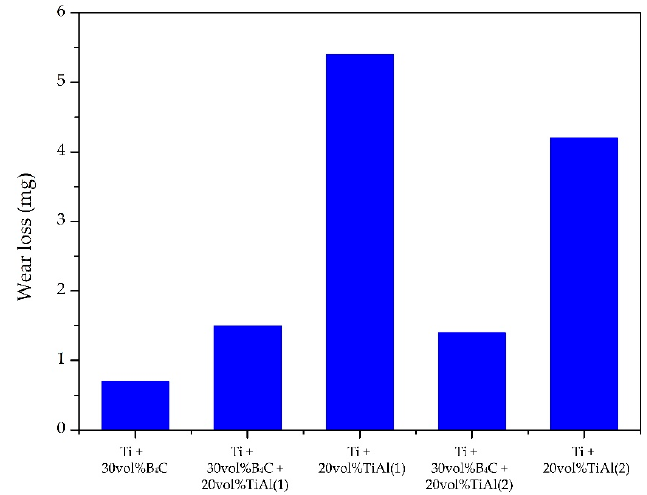
Figure 9. Wear loss vs. specimens.